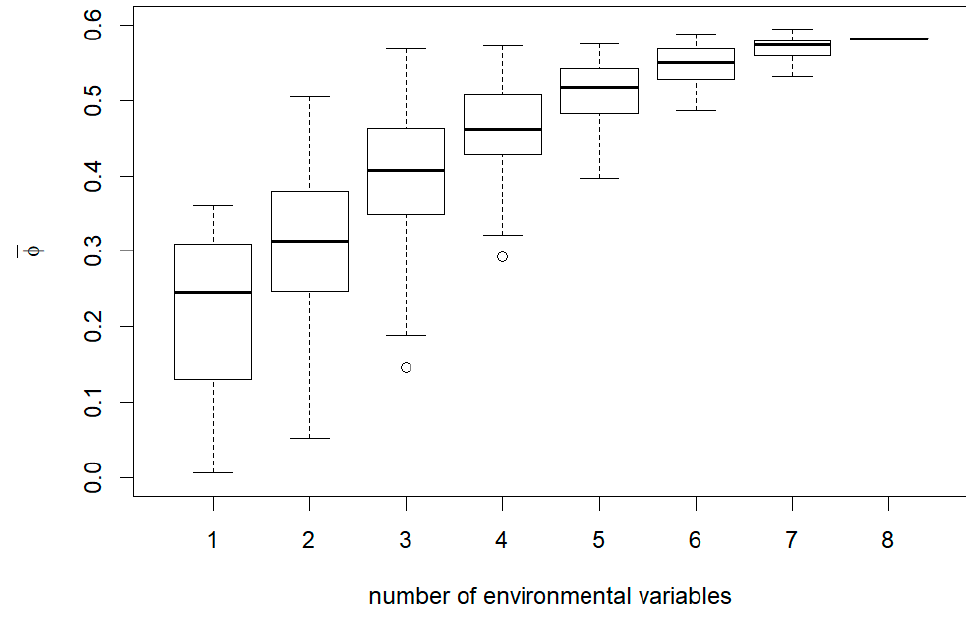
Figure A2. Box plot of mean phi coefficients ( φ ) of the FDMs generated by RFC as affected by the number of explanatory variables. Box plot shows median plus upper and lower quartiles for φ of FDMs with a given number of explanatory variables. Minimum and maximum values are indicated by the upper and lower whiskers (1.5 × interquartile range). Circles are outliers.